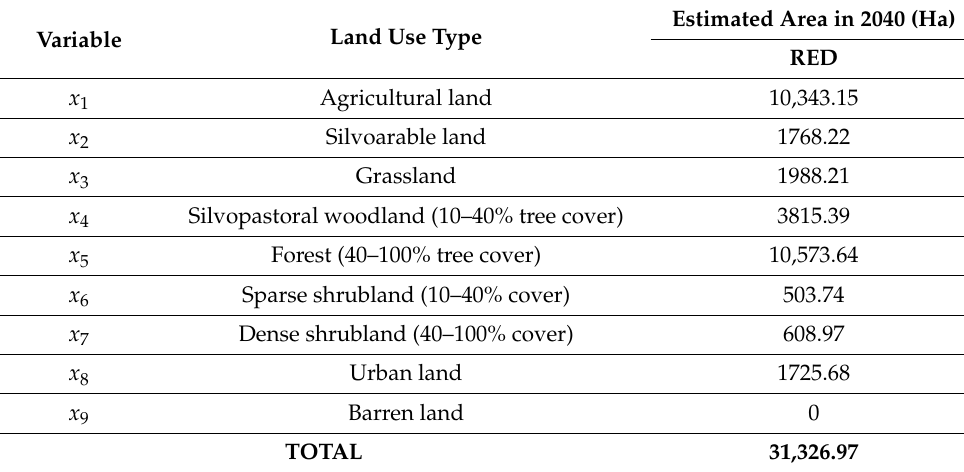
Table 7. Estimated area in 2040 (Ha) under RED scenario, after relaxing constraint C5.